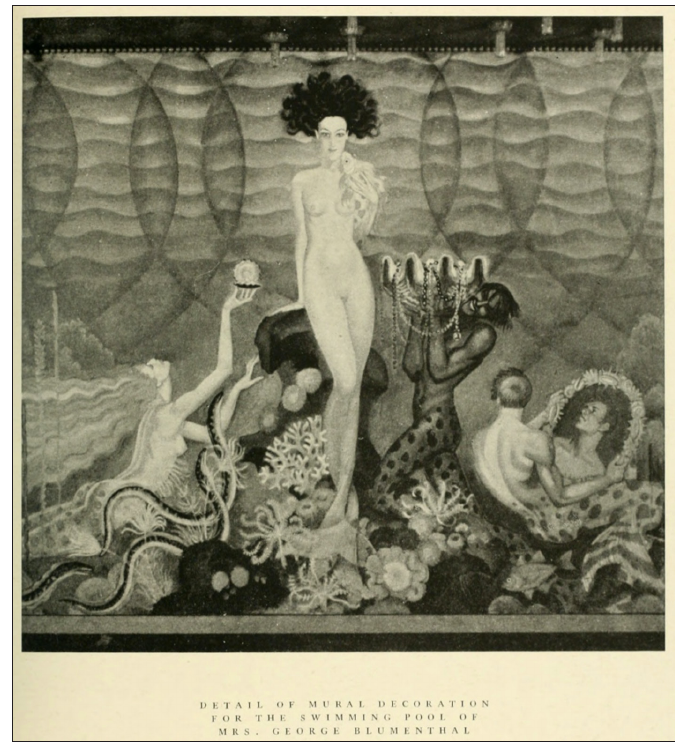
Fig. 2 : Paul Thévenaz, Detail of mural decoration for the swimming pool of Mrs George Blumenthal, in Paul Thévenaz: A Record of His Life and Art (New York: Privately printed, 1922),